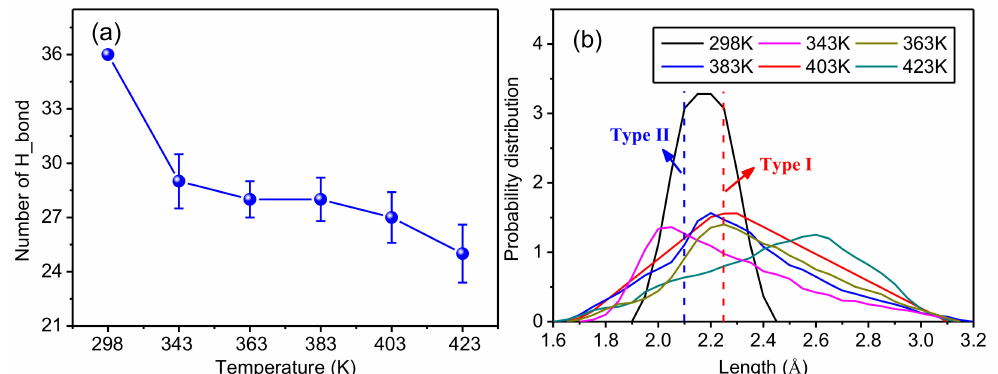
Figure 11. Influence of temperature on the hydrogen bonding network in crystalline regions of meta-aramid fibers. ( a ) Relation between temperature and the number of hydrogen bonds and ( b ) distributions of hydrogen bond lengths at different